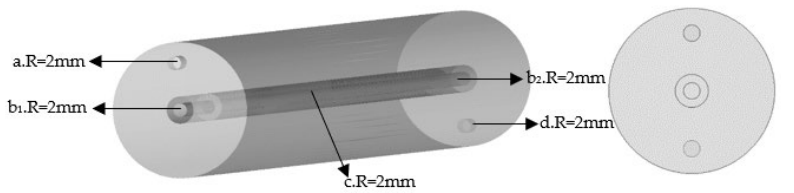
Figure 1. The structure diagram of each zone of the flow channel of the membrane pool, a: inlet; b1: outlet1; b2: outlet2 c: porous media semipermeable membrane; d: outlet.